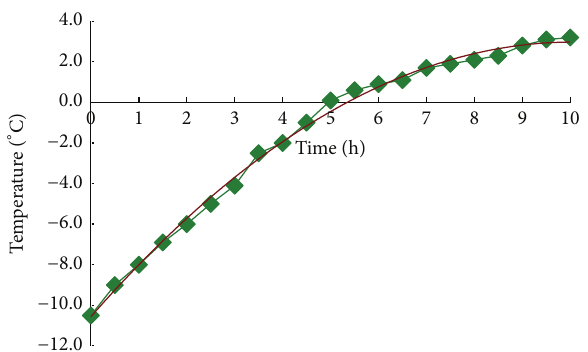
Figure 14: Temperature curve of the specimen surface with air temperature of − 10 ∘ C.